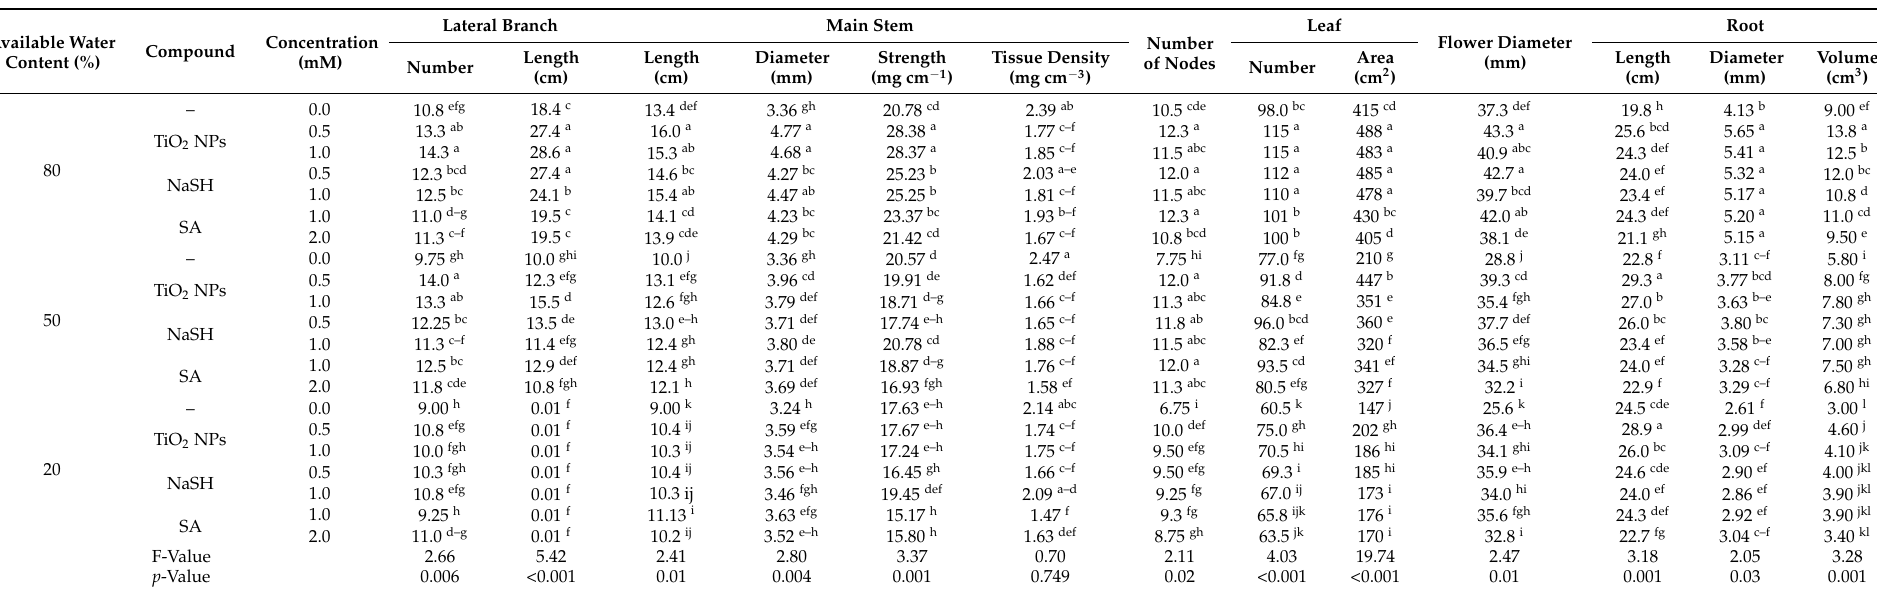
Table 3. Morphological features of periwinkle ‘Pacifica XP Really Red’ plants receiving exogenous application of titanium dioxide nanoparticles (TiO 2 NPs; 0, 0.5 and 1 mM), sodium hydrosulfide (NaSH; 0.5 and 1 mM), or salicylic acid (SA; 1 and 2 mM) under different watering levels (80, 50 and 20 % available water content) during cultivation. Means followed by different letters indicate significant differences ( p = 0.05; comparison in columns). Values are the mean of four